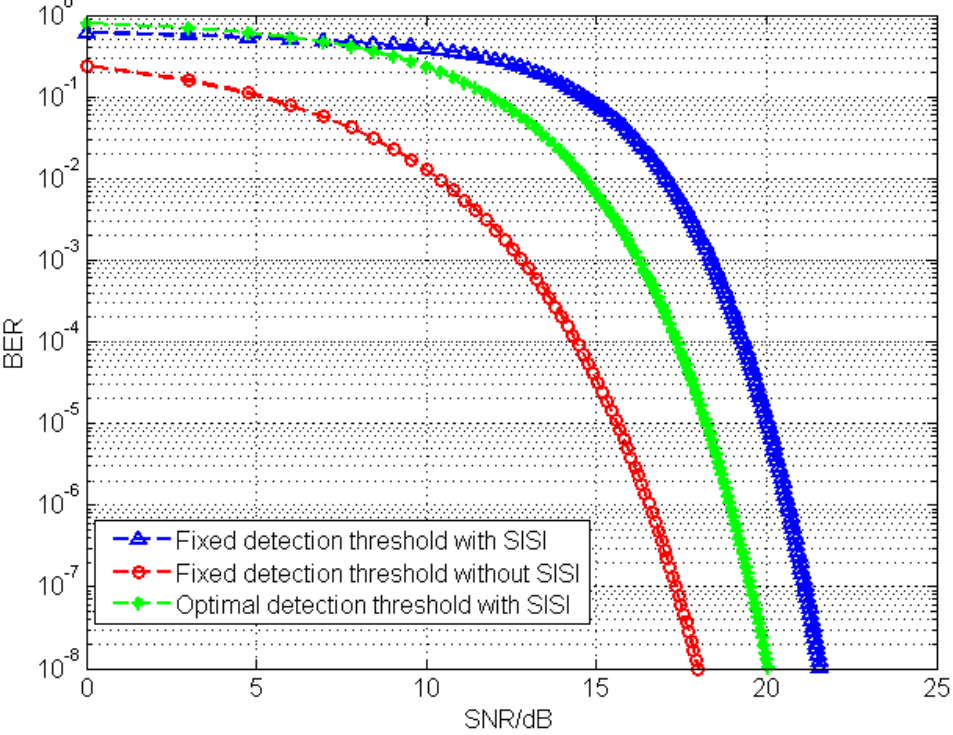
Figure 11. The impact of SISI and detection threshold on BER performance.